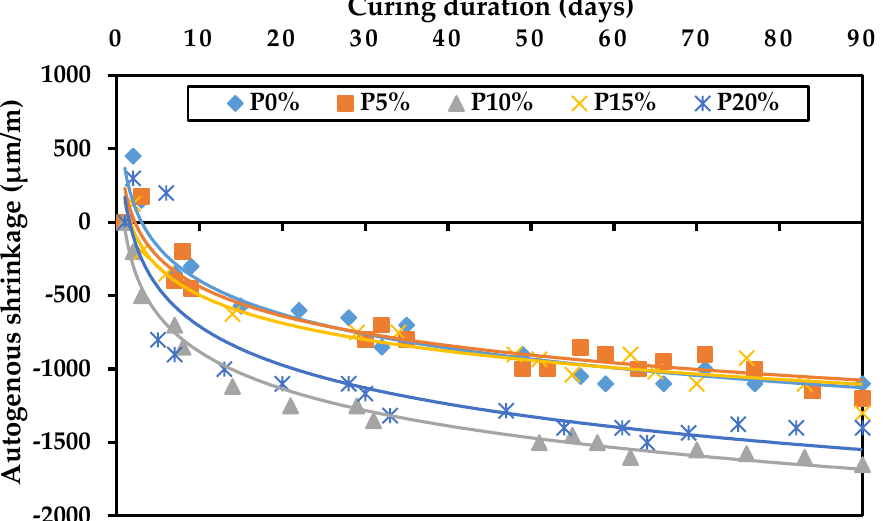
Figure 8. Autogenous shrinkage of pastes with different percentages of LF.